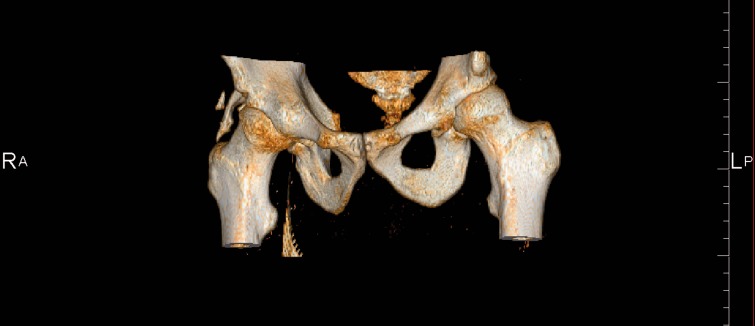
3D CT reconstruction of a 34-year-old triathlete showing grade 3 HO with acetabular origin and posterolateral location of the HO.